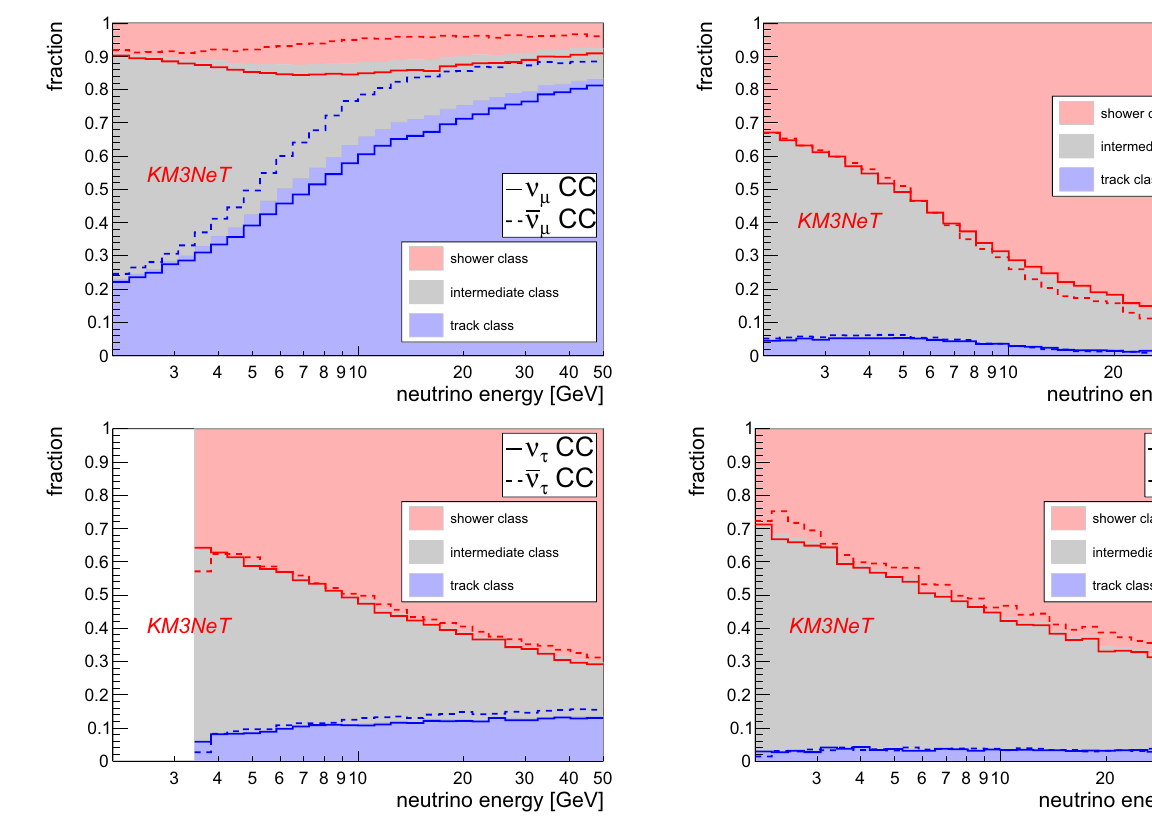
is given in Eq. 2. Coloured areas correspond to the composition of the atmospheric neutrino flux. Solid and dashed lines show individual frac- tions for neutrinos and anti-neutrinos,